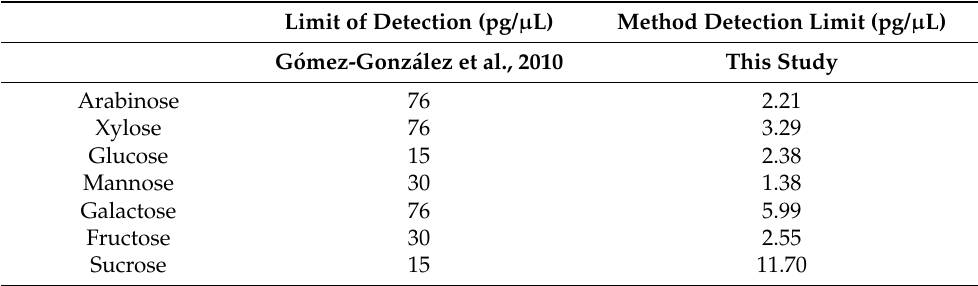
Table A2. Detection limits of saccharides using GC-MS/MS coupled with silylation derivatization in a previous study and this